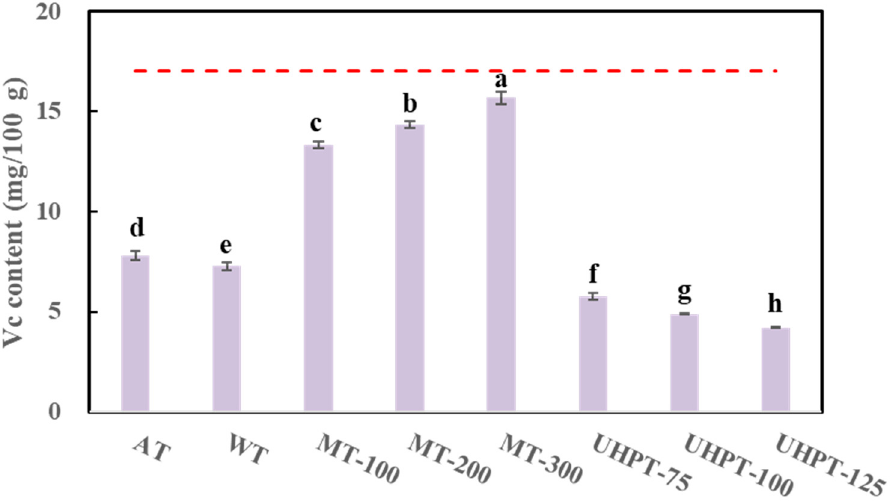
Figure 5. The vitamin C content of thawed mangoes that were affected by different thawing condi- tions. The dotted line represents the vitamin C content of the fresh mango. The different lowercase letters mean the significant difference among thawing conditions ( p < 0.05).